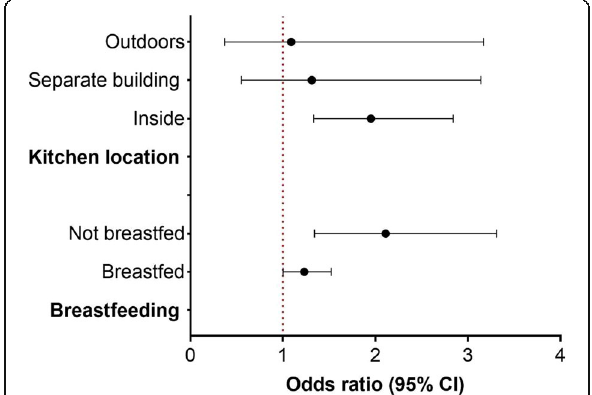
Fig. 3 Stratified analyses by kitchen location and breastfeeding status